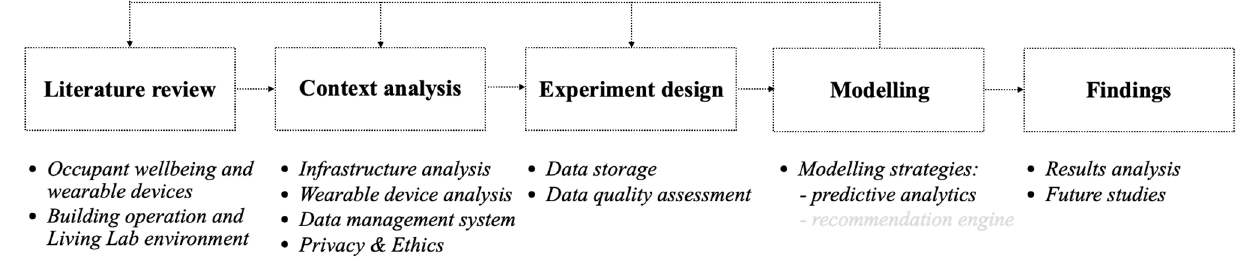
Figure 4. Research process.